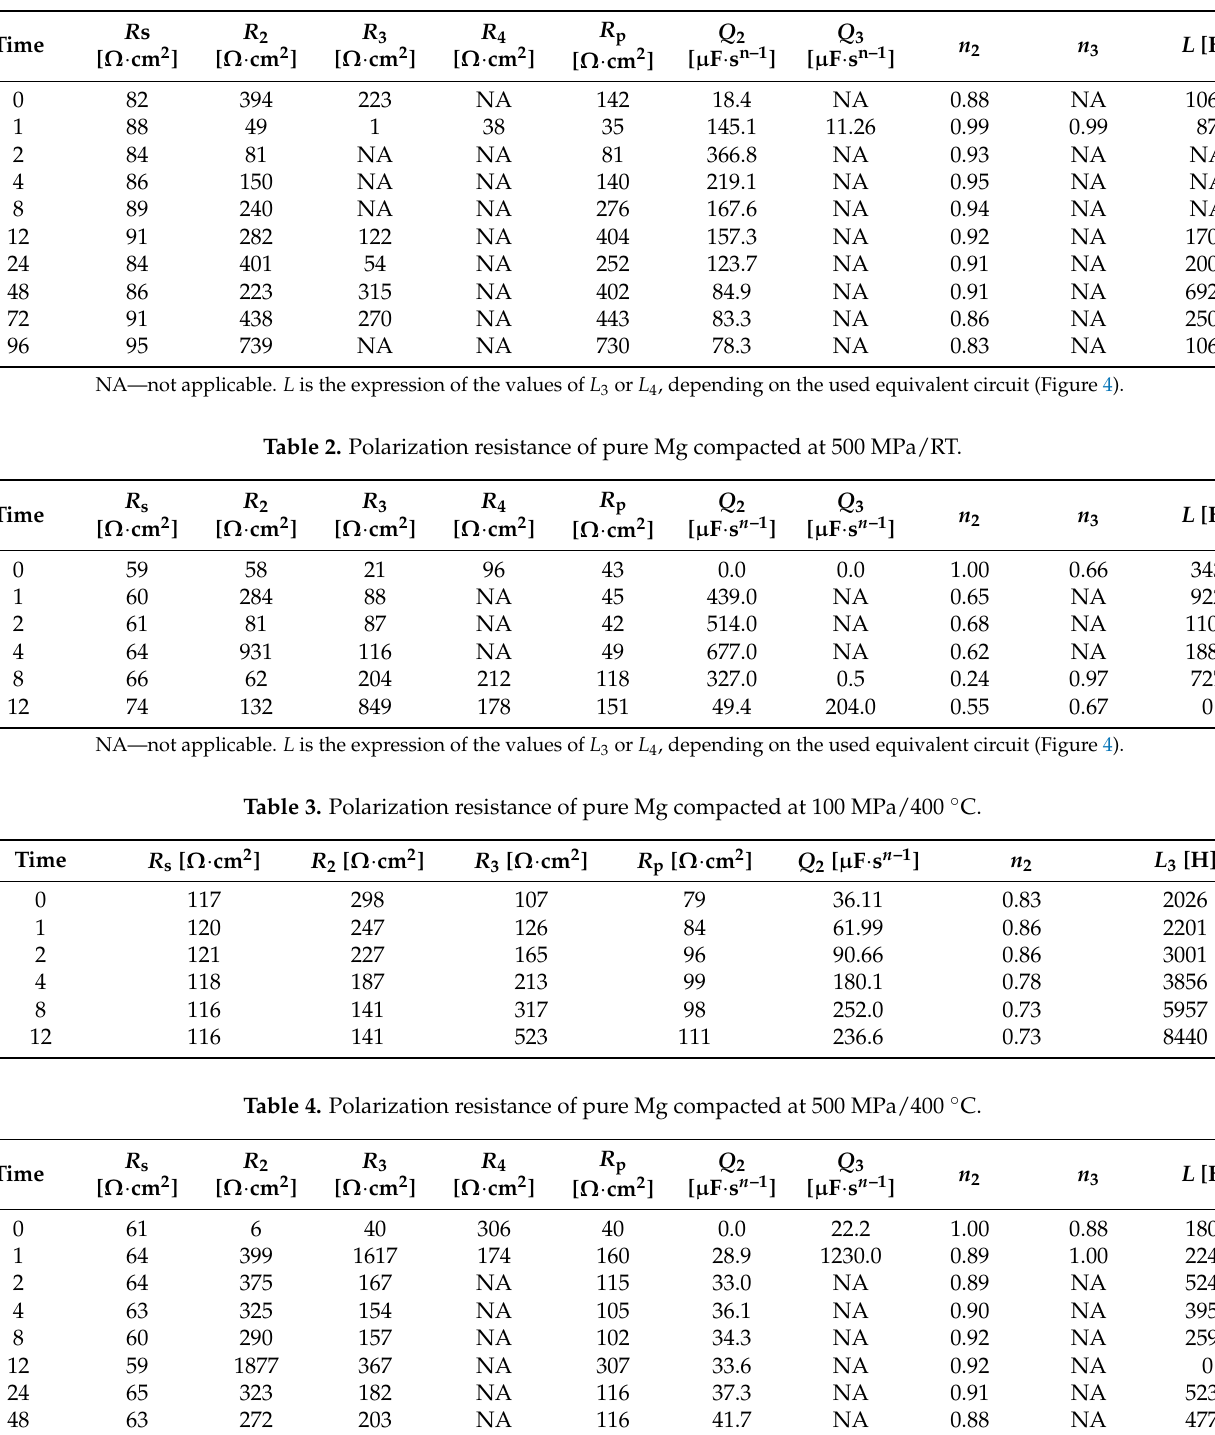
Table 1. Polarization resistance of wrought pure Mg.